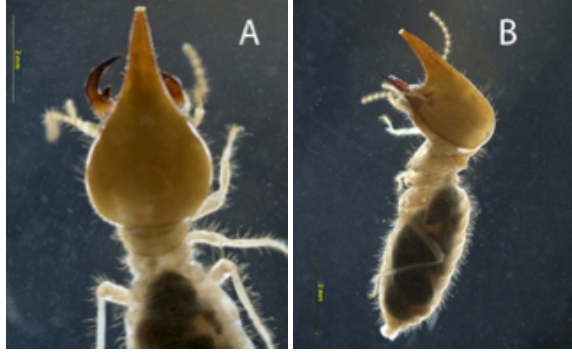
Image 6. Rhynchotermes amazonensis Constantini & Cancello (2016)